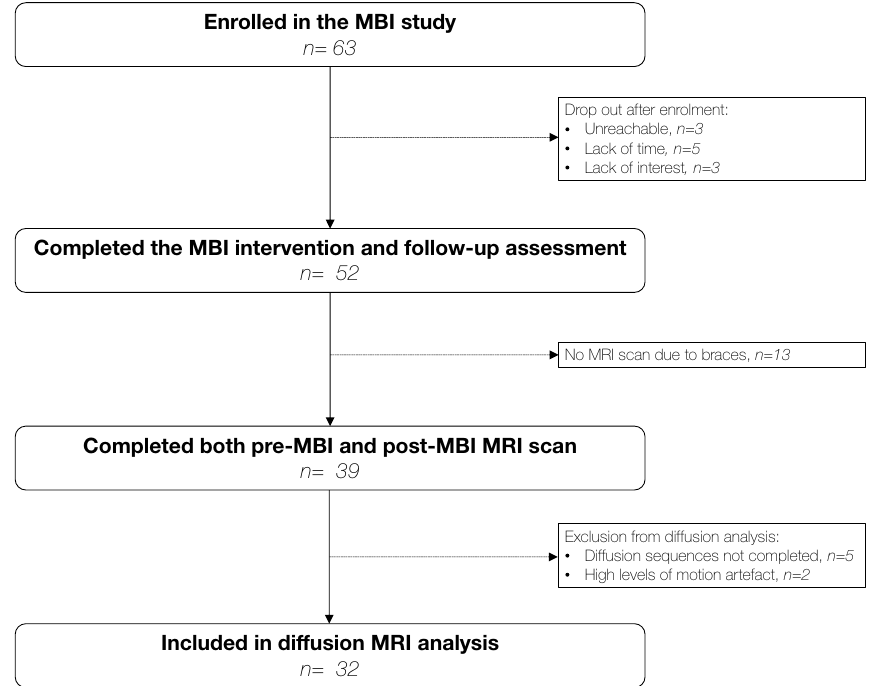
Figure 1. Participant flow chart. This figure shows the number of young adolescents who were enrolled into the MBI study, and of these, the number who had usable scans at both pre- and post-MBI time points and were thus included in the current analysis 21, 22 . MBI, Mindfulness-based intervention; MRI, magnetic resonance imaging.